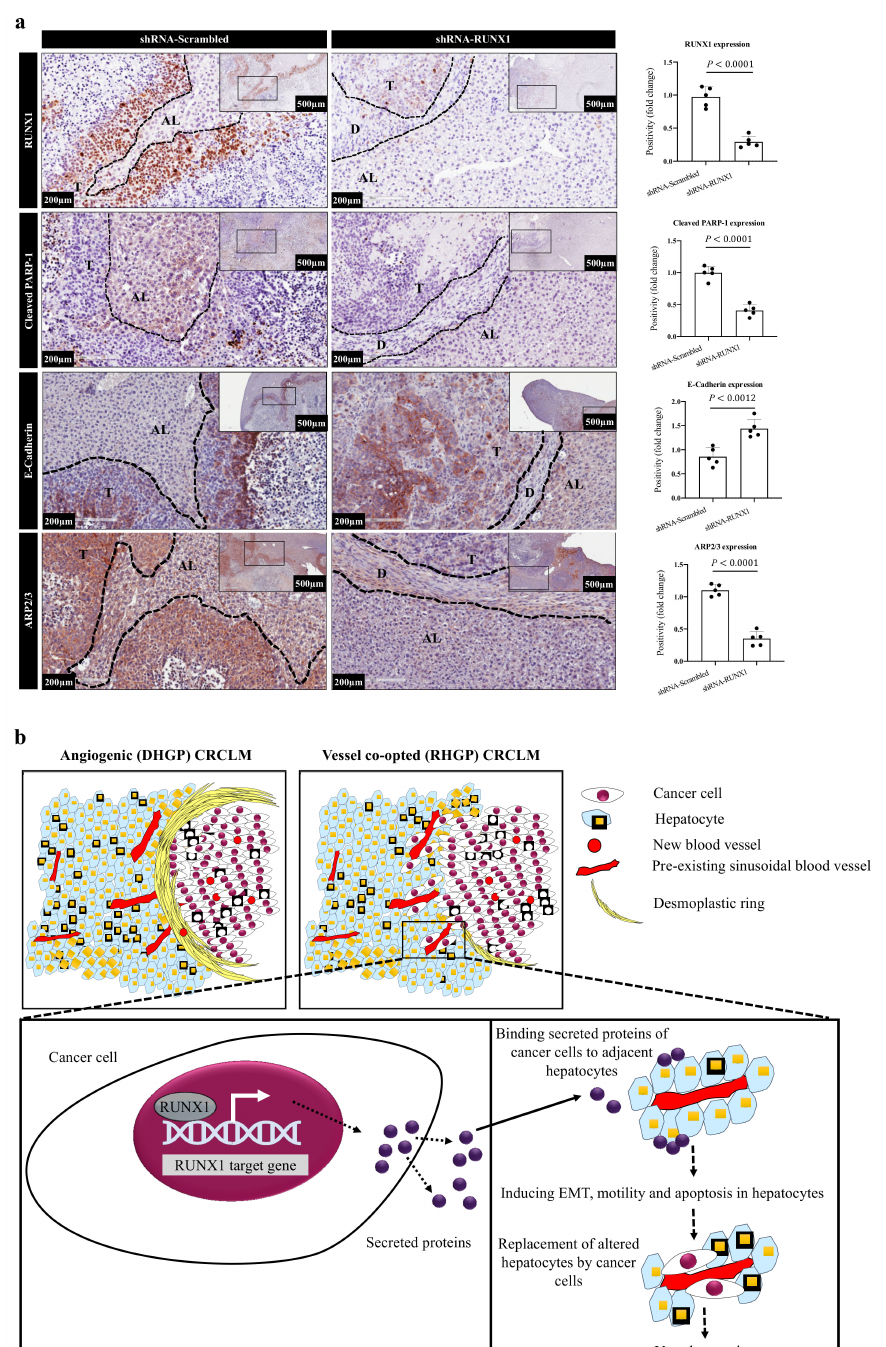
Figure 6. RUNX1 plays a critical role in the interaction between cancer cells and hepatocytes in vivo. ( a ) represents immunohistochemical staining of liver metastatic tumour sections that were generated using HT29 cancer cells expressing shRNA control or shRNA against RUNX1. AL—adjacent liver; D— desmoplastic ring; DL—distal liver; T—tumour. The right panels represent quantification of staining positivity that was assessed in the specimens using Aperio software. ( b ) Schematic illustration showing the main findings in the current study. RUNX1 plays a critical role in the process of hepatocyte displacement by cancer cells. RUNX1 upregulation results in overexpression of its target genes. The expression and secretion of these proteins by cancer cells may stimulate apoptosis, EMT and/or motility of hepatocytes in the surrounding liver. Through these processes, cancer cells induce hepatocyte displacement and replacement around the pre-existing blood vessels and occupy their space to form vessel